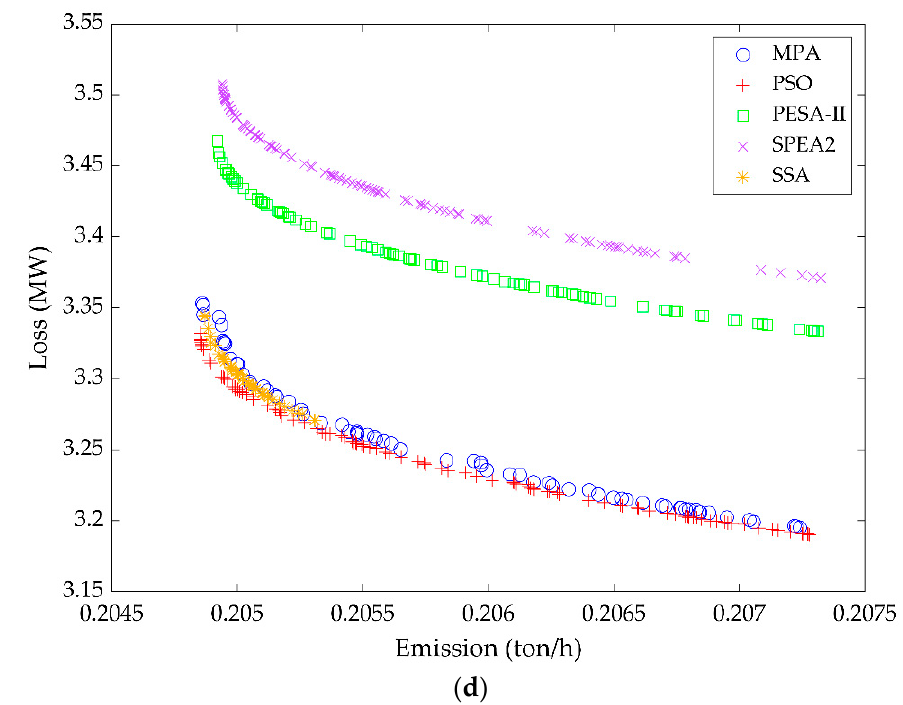
Figure 4. Two-dimensional Pareto fronts for: ( a ) case 9; ( b ) case 10; ( c ) case 11; ( d ) case 12.